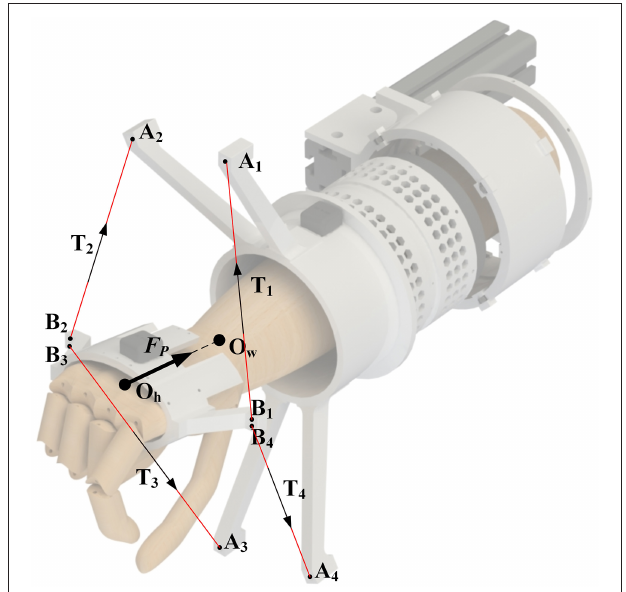
FIGURE 1 | The definition of the parasitic force: O w is the center of the wrist joint, O h is the center of the hand, A 1 − 4 are four cable attachments of the forearm module, B 1 − 4 are four cable attachments of the hand ring, T 1 − 4 is the cable tension, and F p is the parasitic